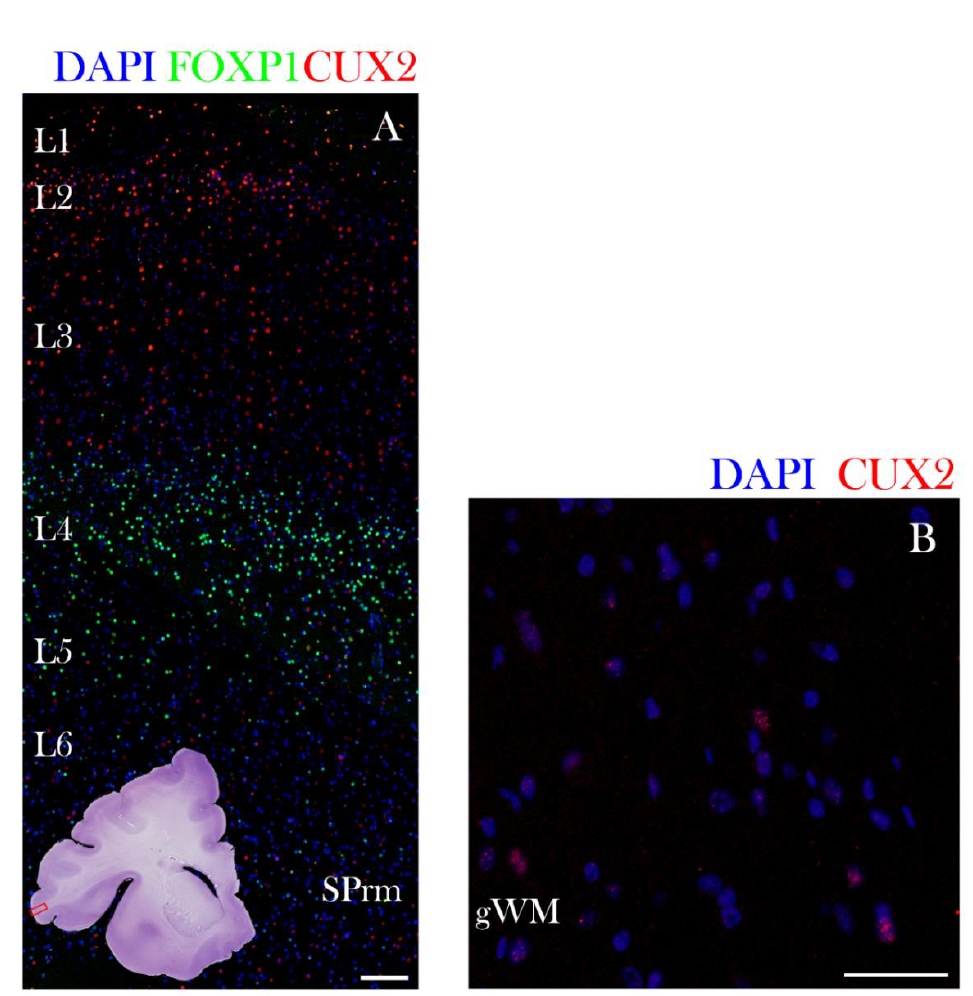
Figure 9. CUX2 is expressed in upper layers at the SP resolution phase at 38 PCW. Representative confocal images of lateral dorsal part of the cerebral cortex in the prospective operculum (indicated by red box on the inset representing complete scan of coronal Nissl section shown in lower left corner of A) are shown on the following sections ( A,B ). Developing neocortex was immunostained for CUX2 (red), neuronal subtype marker FOXP1 (green), and DAPI (blue). During the SP resolution phase (38 PCW), inferior frontal gyrus cortex exhibits strong CUX2 expression in layers 1–3, as well as in the SP remnant (SPrm) (A). Gyral white matter (gWM) contains a portion of cells positive for CUX2 (B). Scale bar = 100 µm.